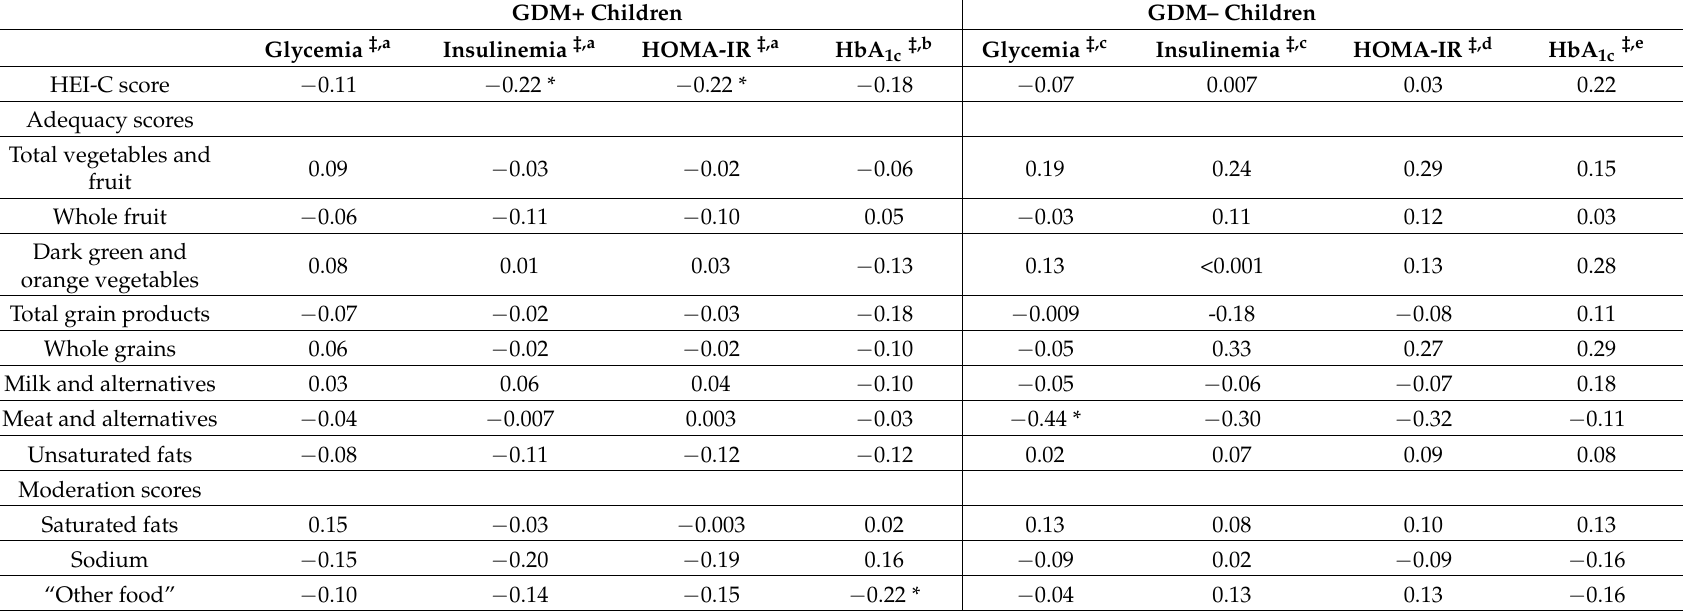
Table 4. Association between diet quality and glycemic profile of GDM+ and GDM–